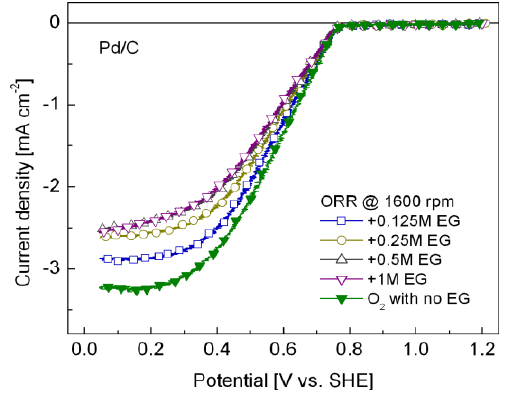
Figure 6. LSVs of the ORR in the presence of increasing concentrations of C (indicated) at Pd/C. Rotation rate: 1,600 rpm. Electrolyte: 0.5 M H 25 °C. Scan rate: 5 mV/s. The polarization curve without EG is also